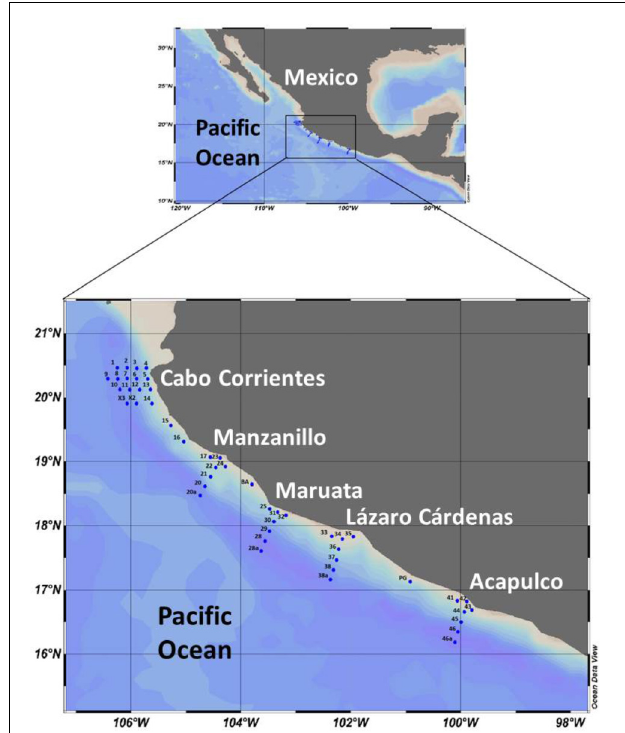
FIGURE 1 | Map of the study area, showing the fixed stations along transects in five zones of the central Mexican Pacific.